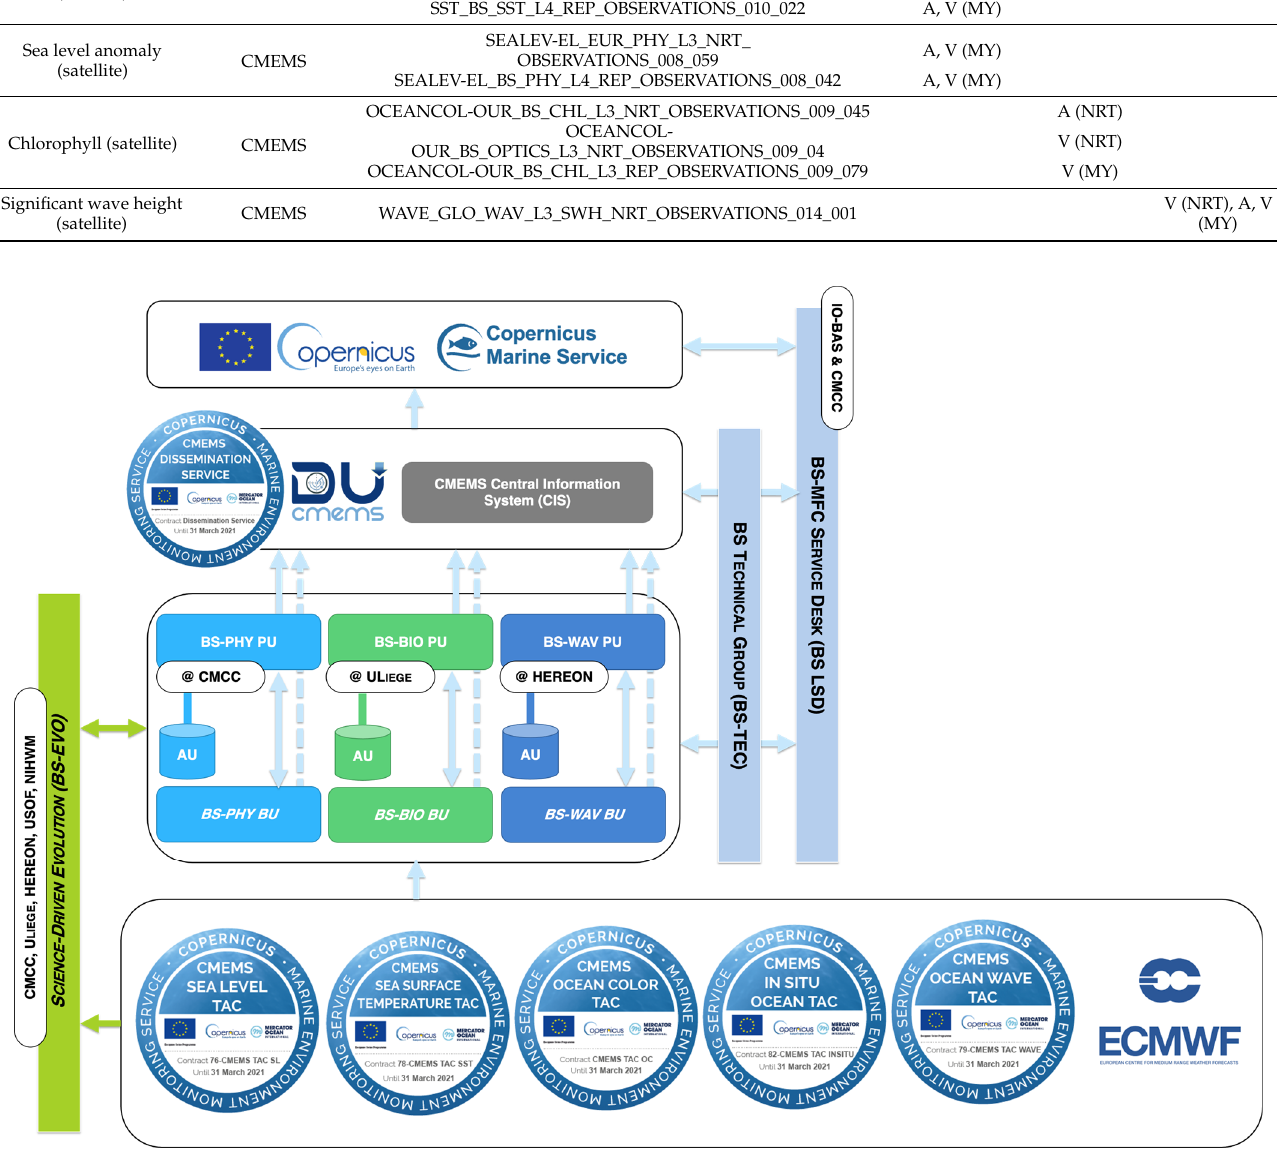
Figure 2. BS-MFC high-level architecture operationally implemented within the CMEMS framework since April 2018.